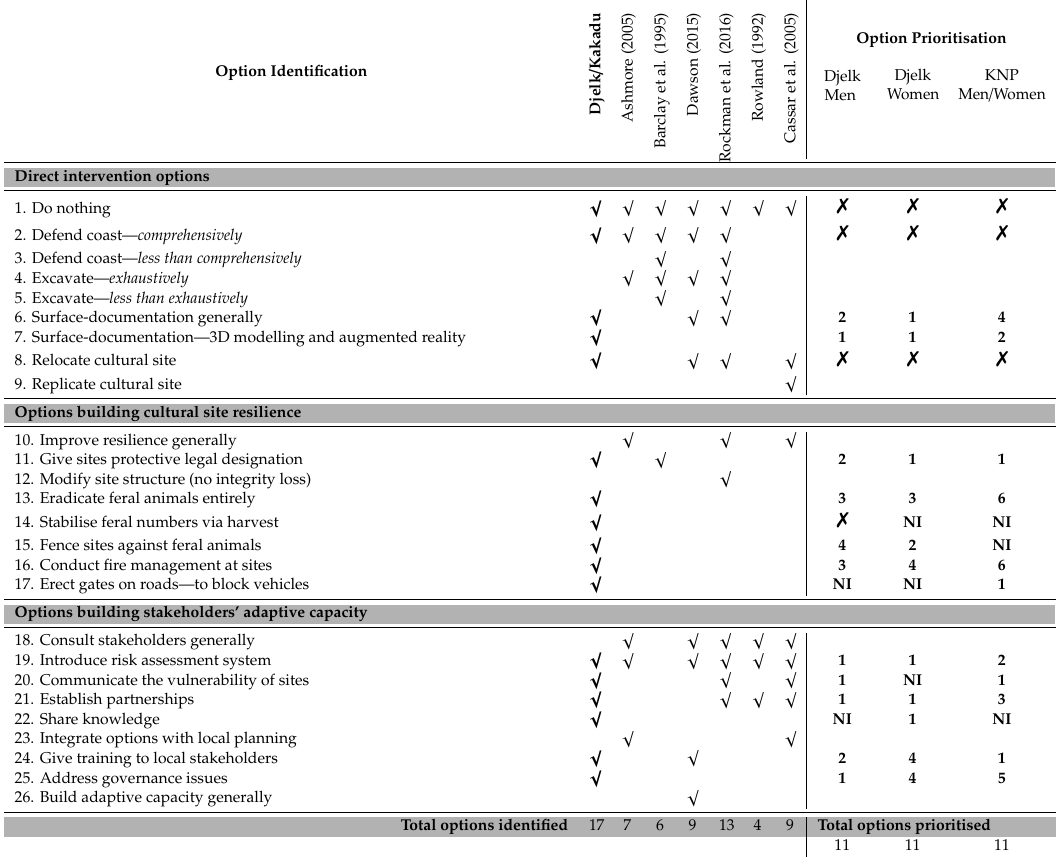
Table 1. Comparison and selection of options-analysis methods. Generic Adaptation Planning Guides